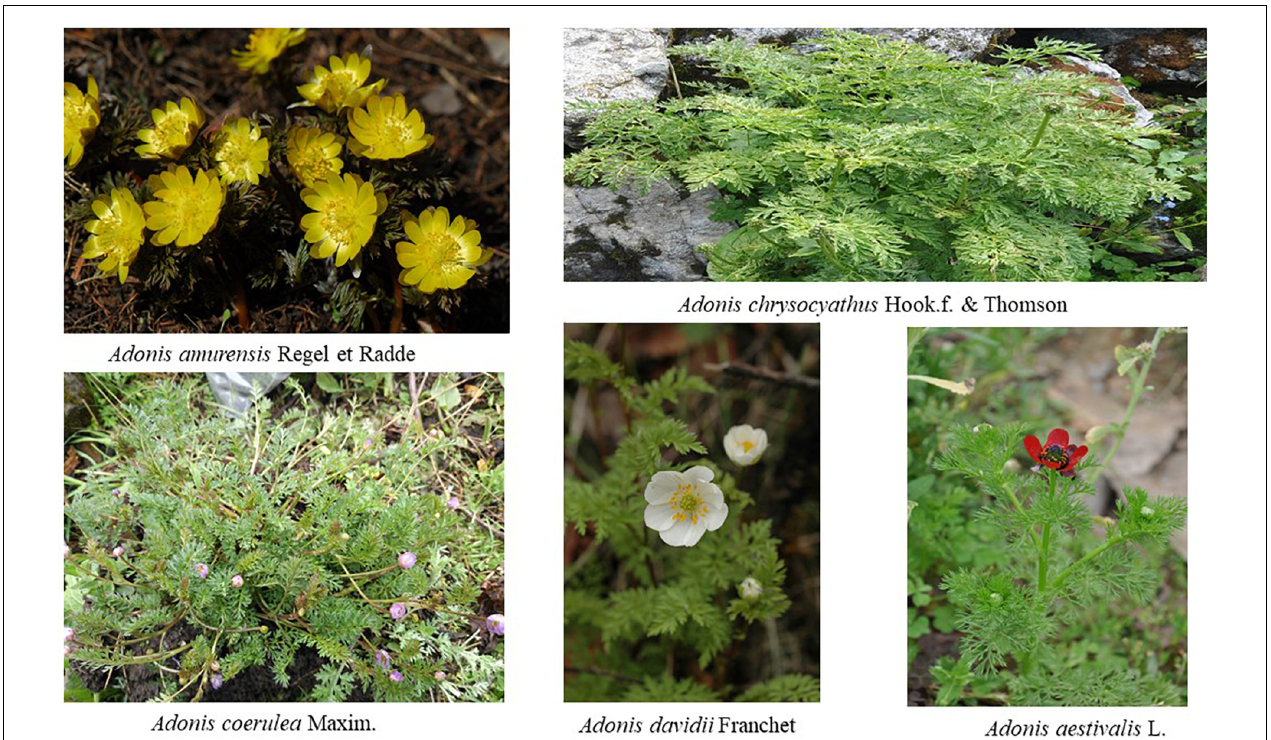
FIGURE 1 | The pictures of five plants grown in